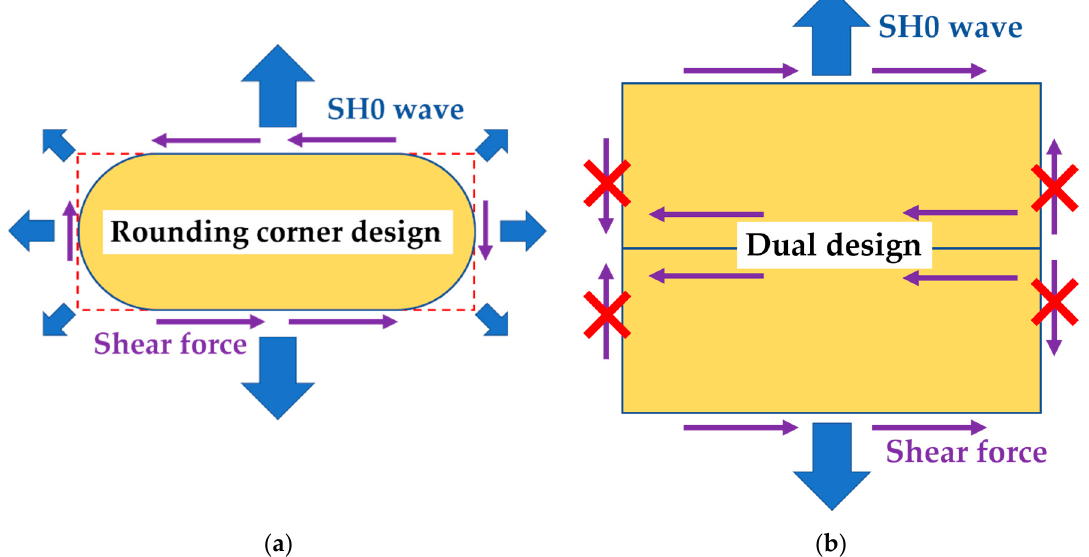
Figure 5. Two modified SHPFP designs. The purple arrows visualize the generated surface traction forces that act as shear forces, and the blue arrows indicate the excited wave modes. The left part shows ( a ) the rounded-corner design and the right part shows; ( b ) the dual SHPFP design. The red crosses in ( b ) indicate that the surface traction forces at the short edges act against each other and should (at least partially) cancel out. It should be noted that two PFPs overlie each other at each active area, even though the underlying and the overlying PFPs cannot be distinguished in the